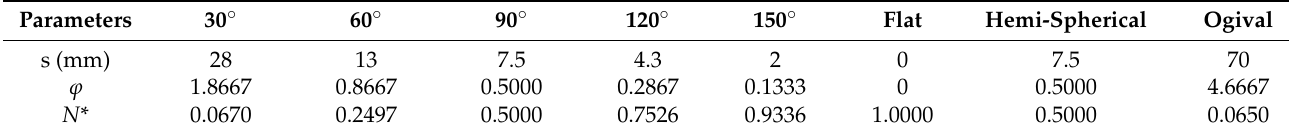
Table 7. The parameters of the projectile nose shape.